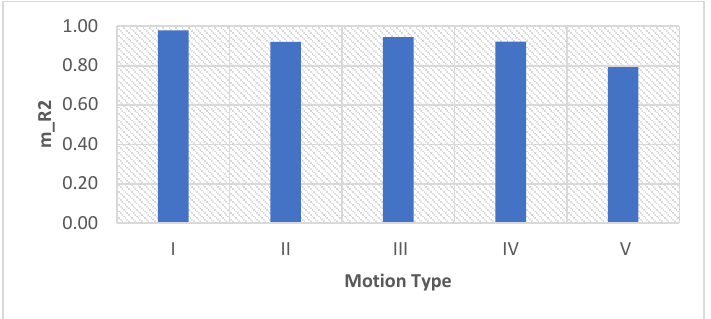
Figure 11. The m_MSE of the denoised ECG signal processed by the proposed method.